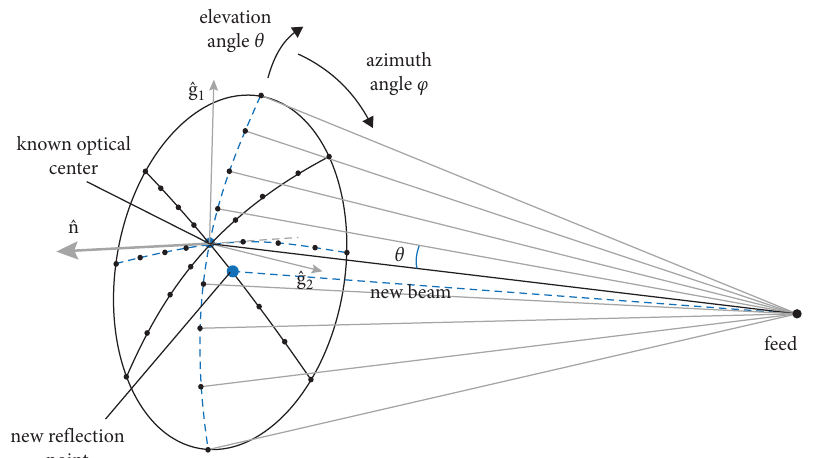
Figure 3: Te solution of the new refection point of the shaped subrefector based on the intersection of the double parabolic expansion